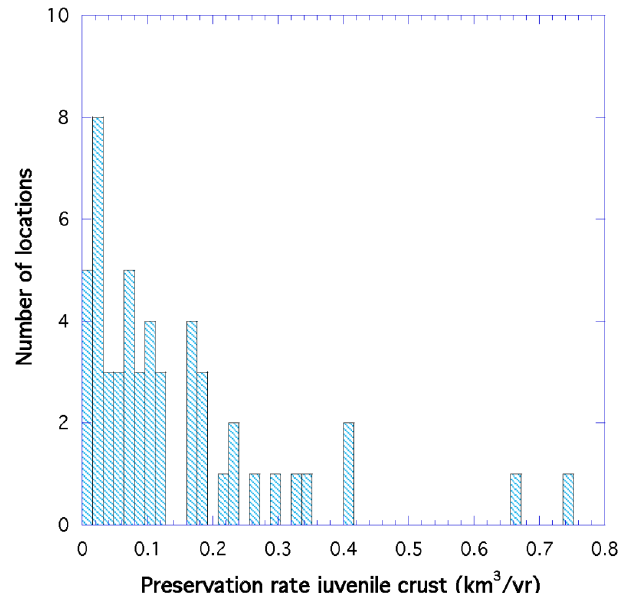
Figure 13. Preservation rate of juvenile crust per year of duration of subduction for Proterozoic orogens (data from Appendix 1, col